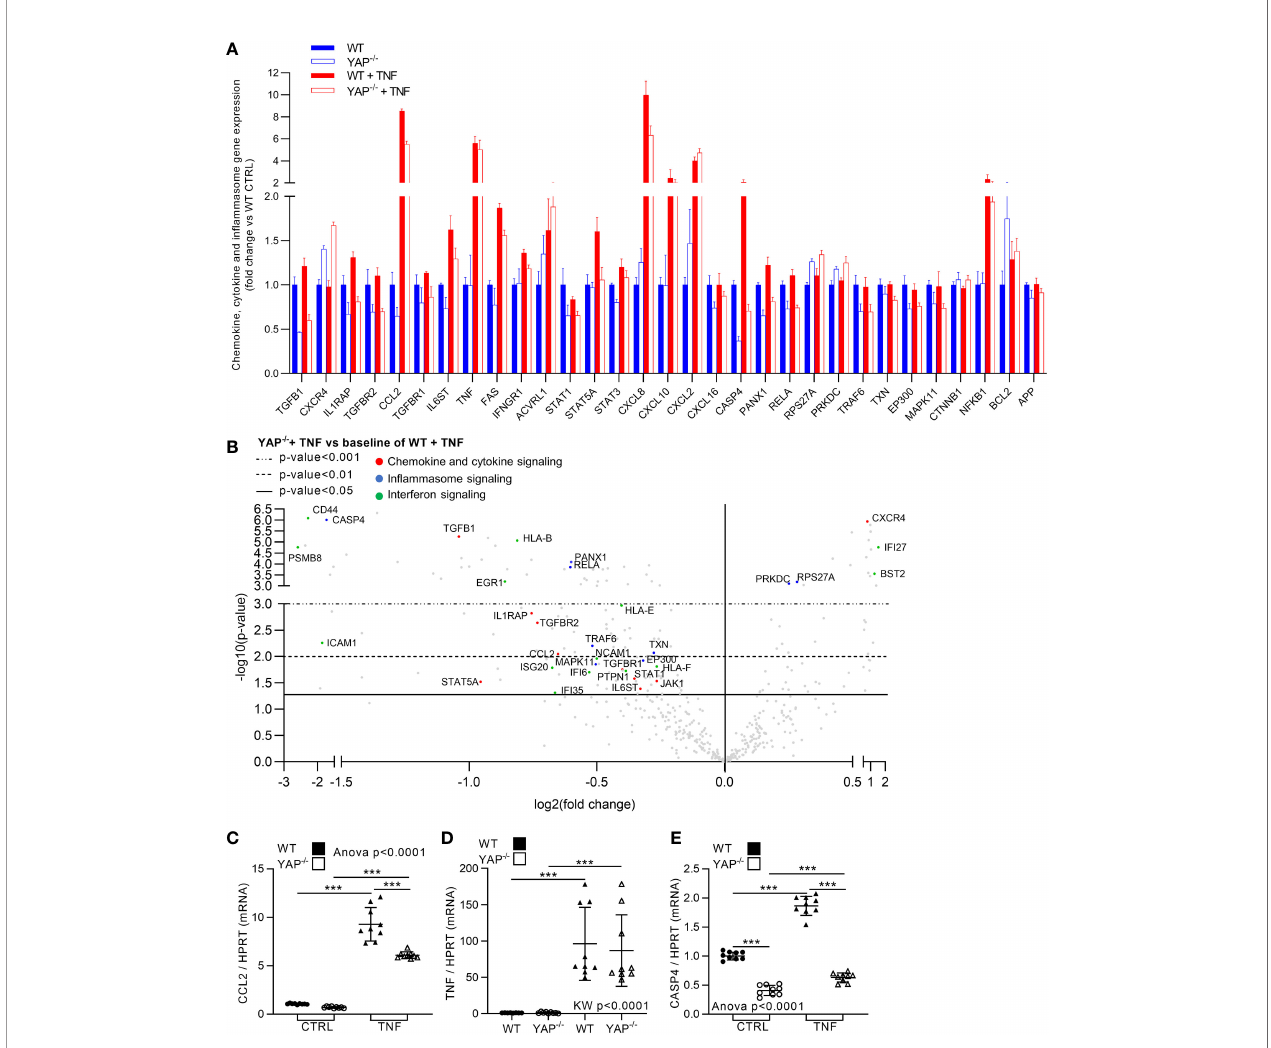
FIGURE 5 | YAP modulates TNF effect on in fl ammatory genes expression. HEK293 cells were cultured and treated with TNF as described in Figure 1 . (A) Nanostring fi brosis panel histogram for in fl ammatory pathways in the four groups; depicted genes were selected if at least one comparison between 2 groups gives a p-value <0.05 and must be related to chemokine, cytokine or in fl ammasome signaling. (B) Volcano plot representation for differential genes expression in YAP − / − + TNF group versus the baseline of WT + TNF group; depicted genes are signi fi cantly differentially expressed and are related to chemokine/cytokine (red), in fl ammasome (blue) and interferon (green) pathways. (C – E) RT-qPCR quanti fi cation of CCL2, TNF and CASP4 expression normalized to HPRT expression. For RT-qPCR, results are representative of three independent experiments with 3 biological replicates for each experiment (n = 9 per group) with T-test or one-way ANOVA or Kruskal-Wallis (KW) test and FDR corrected for multiple comparisons post hoc tests performed between conditions: ***p <0.001. Data are expressed as fold change vs. control and presented as individual values with mean ± SD (C – E) or presented as histogram with mean + SD (A)